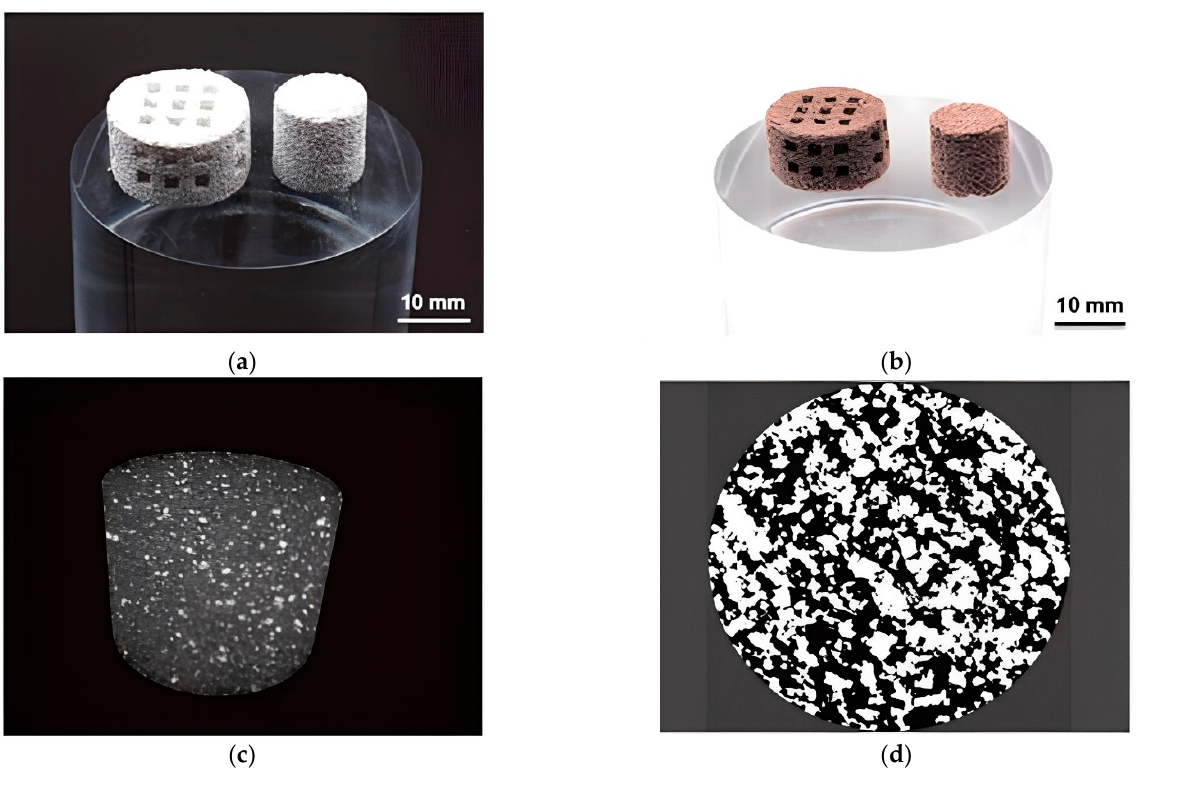
Figure 20. ( a ) FGP samples (scaffolds) with controlled gradient porosity produced by BJ after 3D printing; ( b ) After sintering; ( c ) Three-dimensional maximum intensity projection of FGP samples (scaffolds); ( d ) The binarised cross-sectional microCT images reveal the number of pores (black) (available under Creative Commons license [101]).